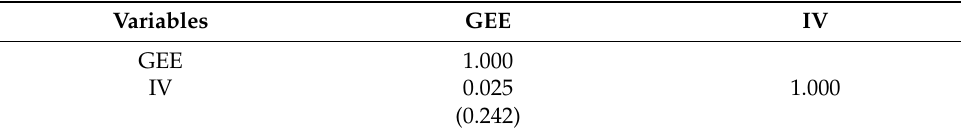
Table A9. Correlation coefficients of IV and